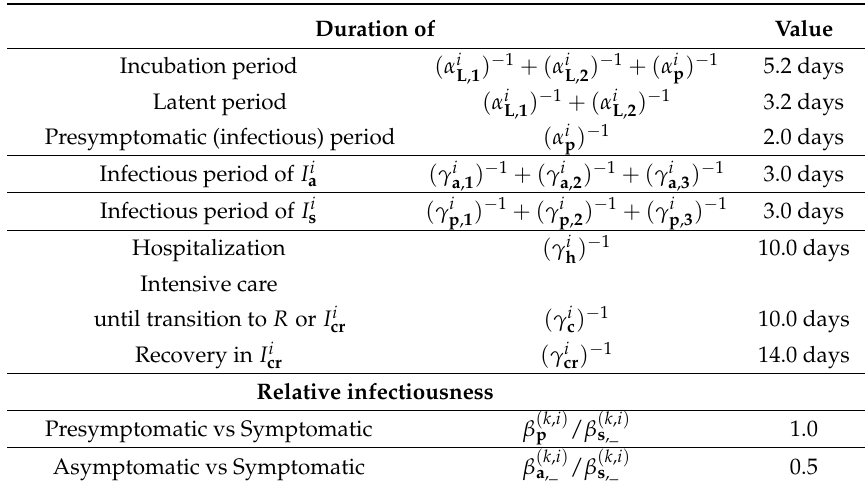
Table 1. Age-independent epidemiological parameters of COVID-19. Assumed to be valid for all age groups. References and explanations are in Section 2.3.2.